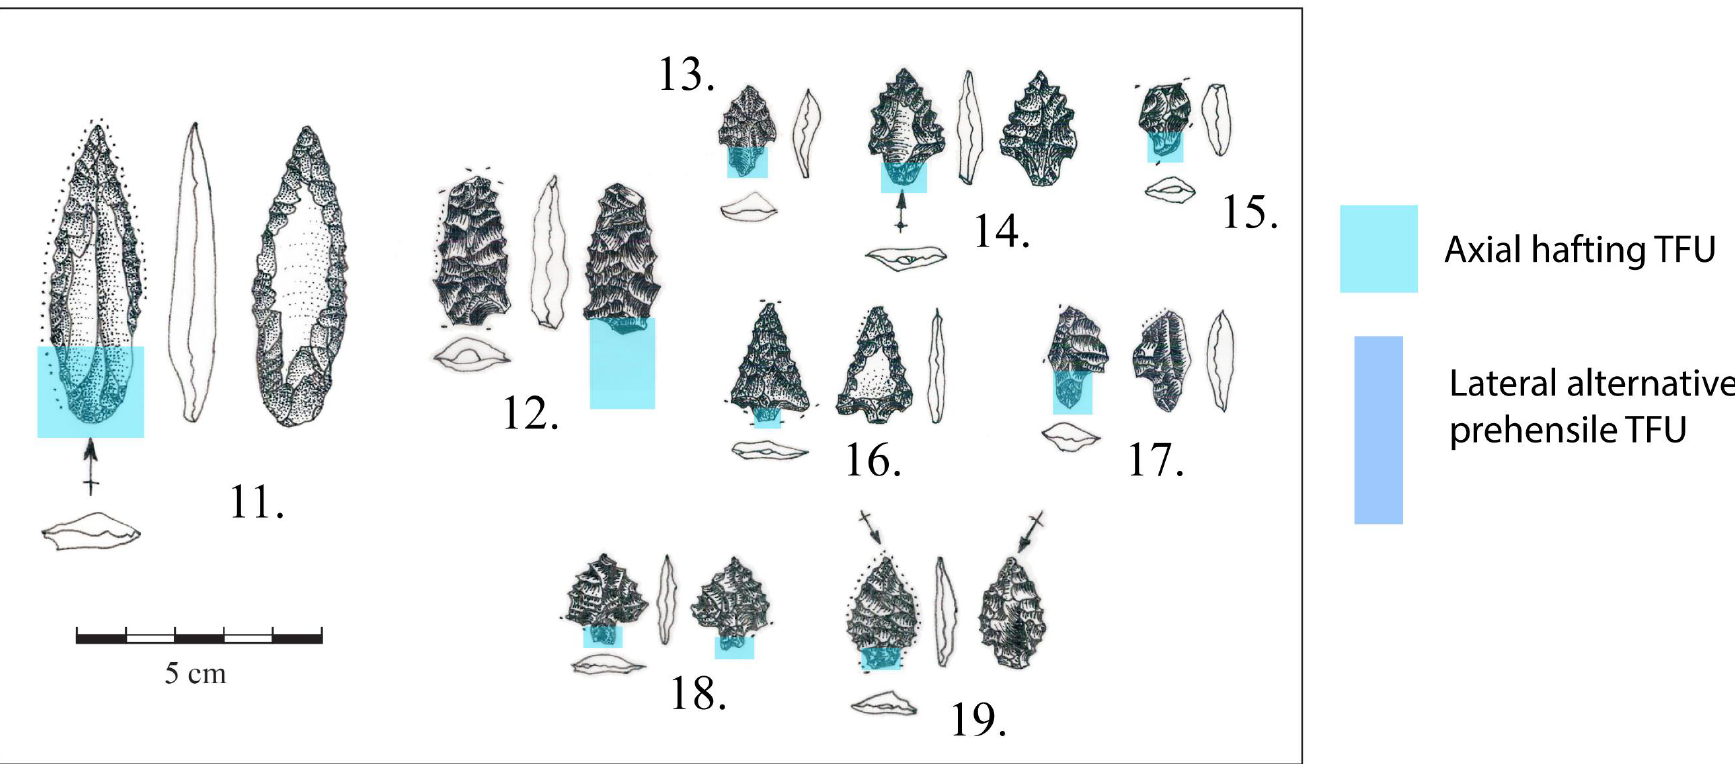
Journal of Lithic Studies (2018) vol. 5, nr. 2, p. xx-xx DOI: https://doi.org/10.2218/jls.2801